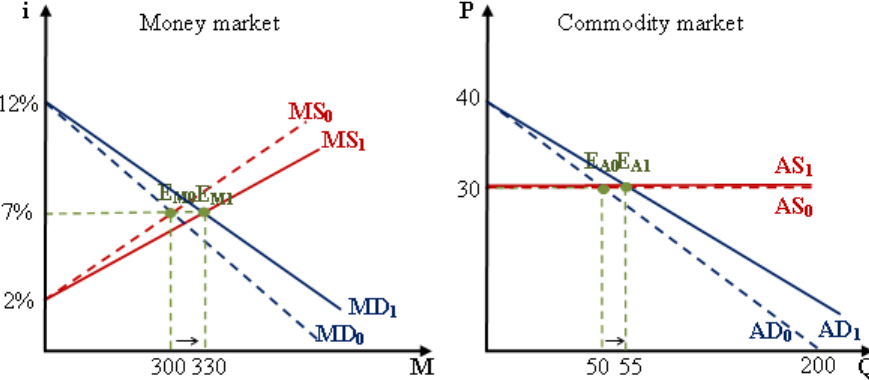
Figure 13. Case of the sticky-price equilibrium economy.